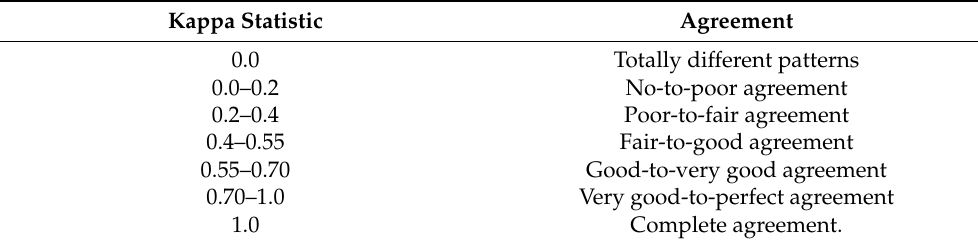
Table 4. The evaluation thresholds of Kappa